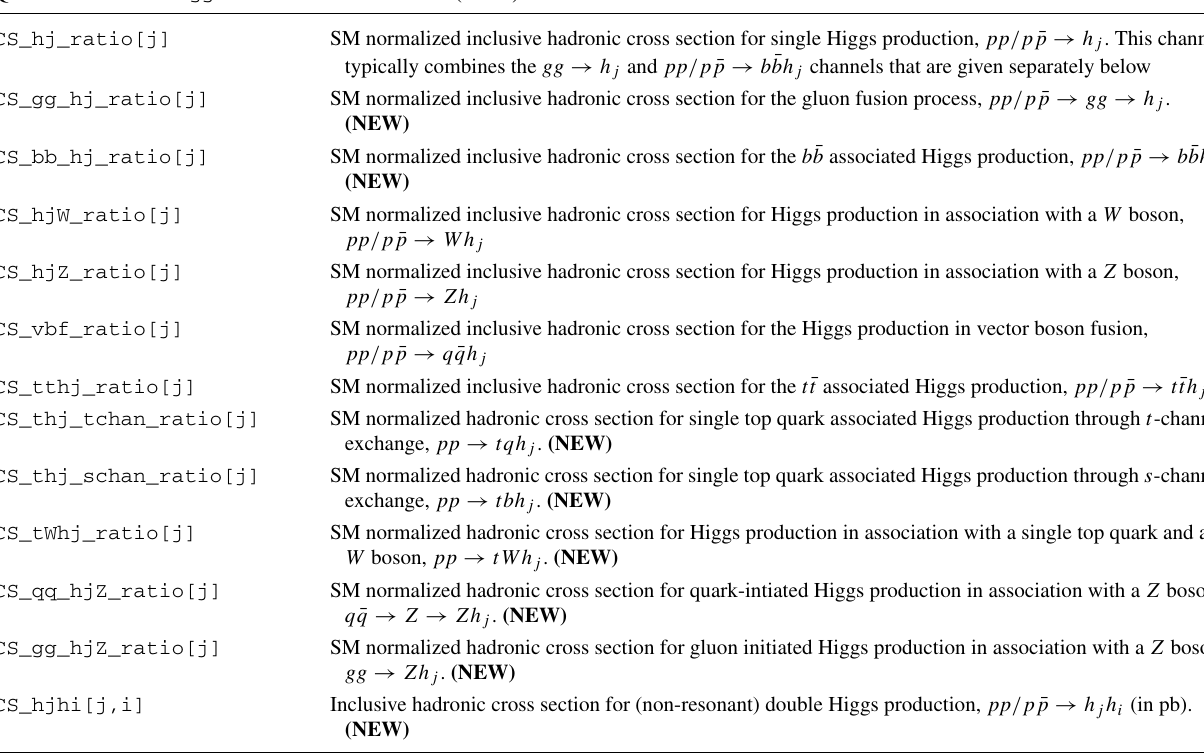
Table 1 Hadronic cross section input for neutral Higgs bosons. The cross sections are inclusive in the electric charges of the produced particles. Quantities added in HiggsBounds-5 are labeled as (NEW) CS_hj_ratio[j] SM normalized inclusive hadronic cross section for single Higgs production, pp / p ¯ p → h j . This